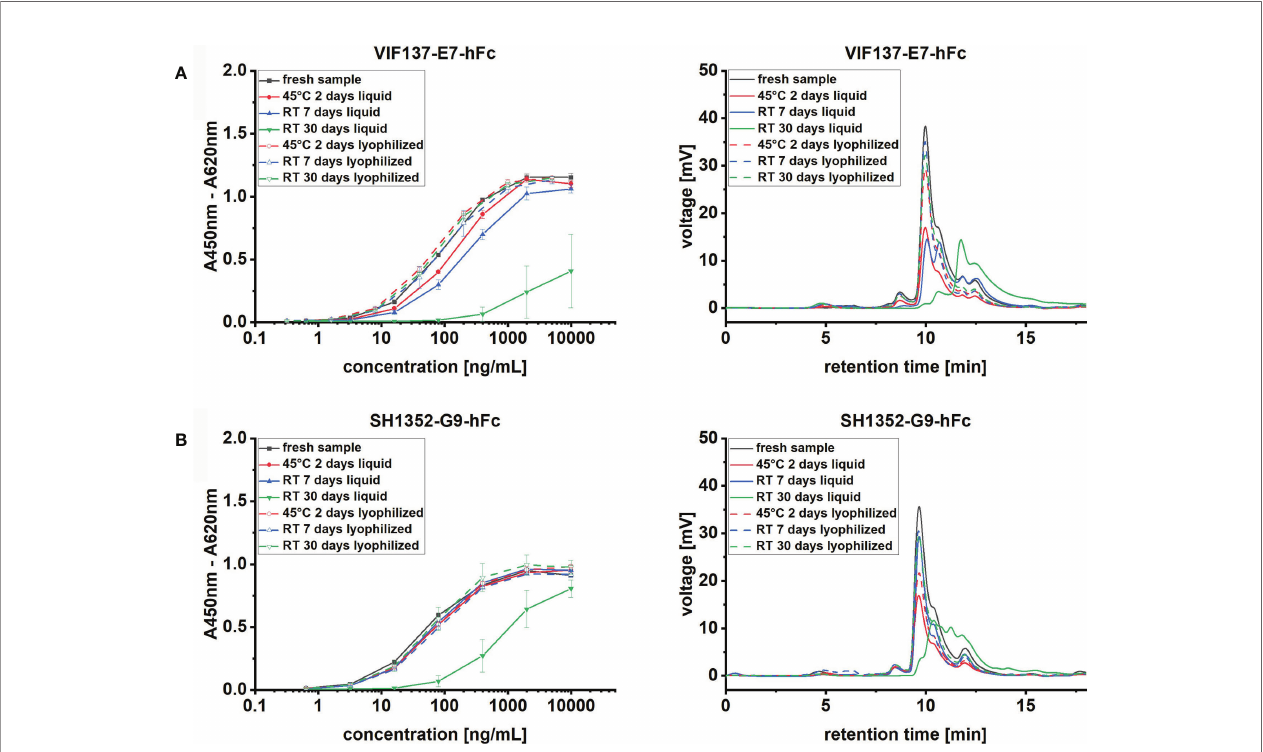
FIGURE 3 | Time course analysis of different scFv-hFc mAbs activity and MM distribution upon storage test. Antibody proteins at 0.5 mg/mL concentration were stored at RT or 45°C, respectively for 7 - 30 or 2 days, in liquid (solid lines) or solid, freeze-dried (dashed lines), state. Left panel: mAb titration binding curves on 100 ng immobilized antigen, right panel, representative SEC chromatograms for each condition for respectively scFv-Fc mAbs (A) VIF137-E7-hFc and (B) SH1352-G9- hFc. All samples after storage are compared to fresh material (black line). ELISA curve error bars result from the analysis of 3 independently lyophilized or liquid stored